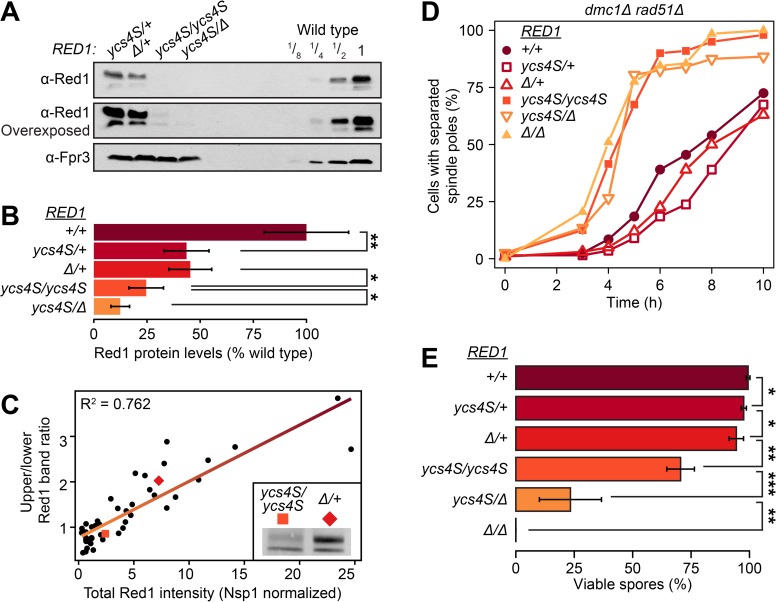
Checkpoint arrest and spore viability require different amounts of Red1 protein.(A) Semiquantitative western blot of a Red1 dosage series. Red1 levels of 2h samples from red1ycs4S/RED1 (ycs4S/+, H8218), red1Δ/RED1 (H8220, Δ/+), red1ycs4S/red1ycs4S (ycs4S/ycs4S, H7011), and red1ycs4S
/red1Δ (ycs4S/Δ, H8219) were compared to a 2-fold serial dilution of a whole-cell extract from wild type (+/+, H7797) from the same time course. Fpr3 was used as loading control. (B) Quantitative measurement of total Red1 protein levels in the dosage series relative to Nsp1 at 2h and 3h, n = 3 per time point. Error bars: S.E.M. *: p-value < 0.05, **: < 0.005, paired Student t-test. (C) Ratio of upper (modified) band to lower (unmodified) band correlates with Red1 protein levels. Red1 levels were normalized against Nsp1. Quantifications come from the gels used in the creation of Fig 1B and Fig 6B. Linear regression of the data is shown along with adjusted R2. Examples of two points are shown in the inset. (D) Spindle pole separation of dmc1Δ rad51Δ (closed circle, H7076), dmc1Δ rad51Δ red1ycs4S/RED1 (open square, H8467), dmc1Δ rad51Δ red1Δ/RED1 (open upward-facing triangle, H8494), dmc1Δ rad51Δ red1ycs4S/red1ycs4S (closed squared, H7088), dmc1Δ rad51Δ red1ycs4S/red1Δ (open downward-facing triangle, H8504), and dmc1Δ rad51Δ red1Δ/red1Δ (closed upward-facing triangle, H6023), n = 200. (E) Spore viability of the Red1 dosage series and red1Δ/red1Δ (H8098), n>100. *: p-value < 0.05, **: < 0.005, ***: < e-5 Student t-test. Samples range in color from dark purple to pale orange as they transition from highest Red1 levels to lowest.